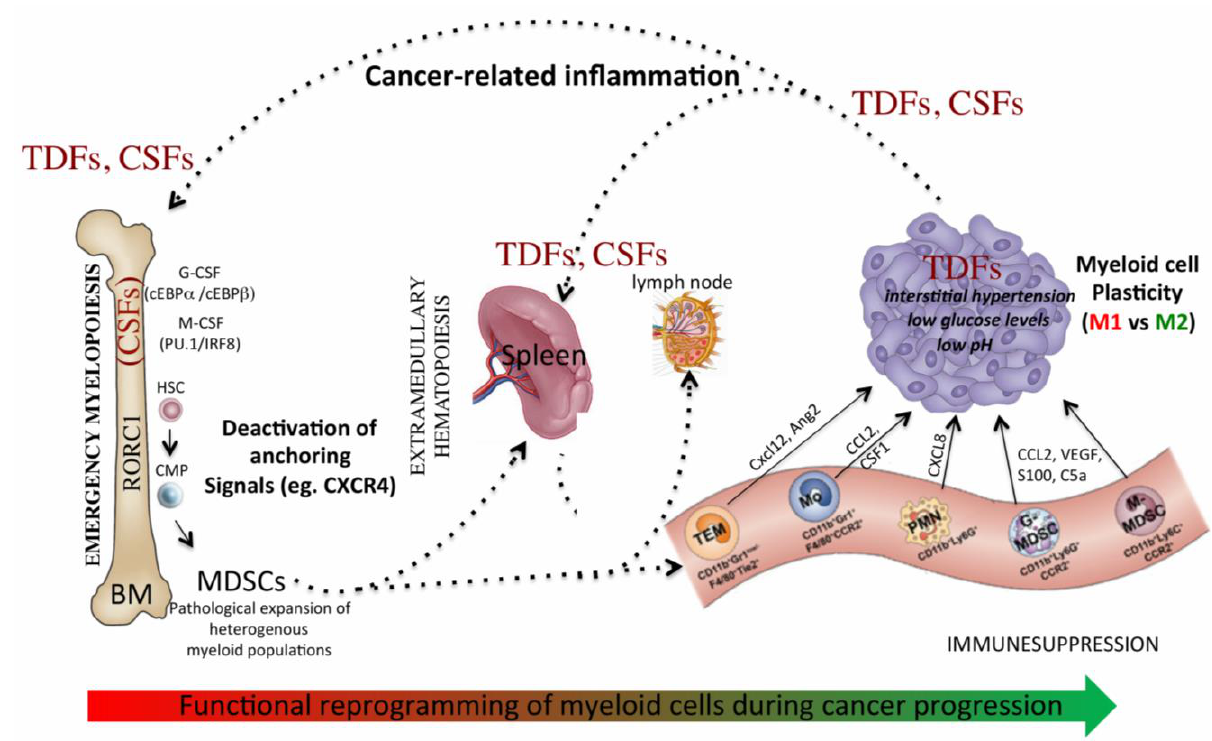
FIGURE 1: Myeloid cell reprogramming in cancer: a dynamic multistep process. Cancer-related inflammation promotes emergency myel- opoiesis through production of colony stimulating factors, such as macrophage-colony stimulating factor (M-CSF), granulocyte-colony stimulating factor (G-CSF), granulocyte-macrophage- colony stimulating factor (GM-CSF). The transcription factor RORC1 is a key mediator of this myelopoietic response in emergency. Deactivation of anchoring signals, such as the retention axis CXCR4/CXCL12 promotes mobili- zation of myeloid cells to periphery and allows their accumulation to lymphoid organs, as well tumor tissues. Recruitment of myeloid